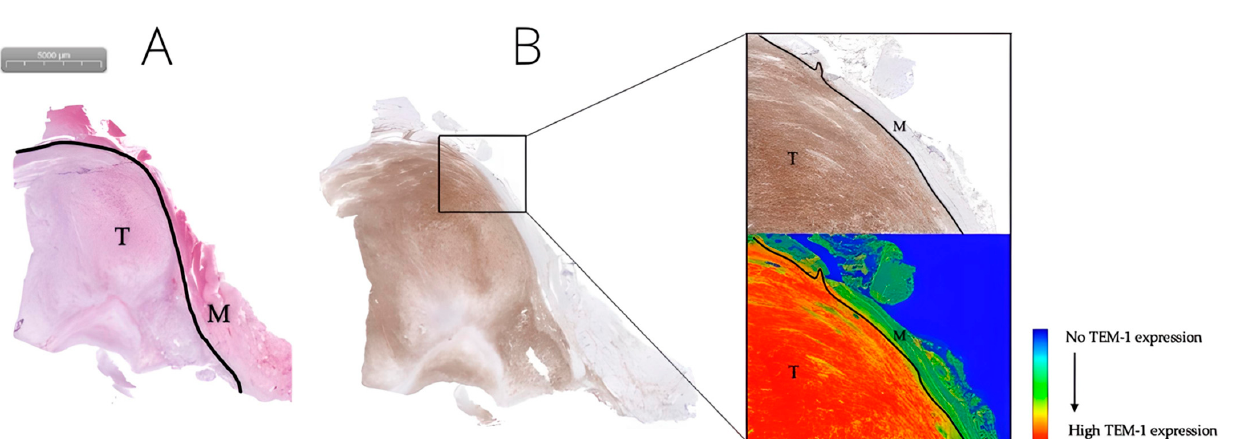
Figure 1. Tissue intensity difference between tumor and adjacent healthy tissue per sample. Exact mean staining intensity values per case are displayed on the left- and right-hand y-axes. TEM-1 displays the highest difference in tumor- versus-adjacent healthy tissue staining intensity. For three cases, VEGF-A staining intensity and PDGFR- α staining intensity were higher in adjacent healthy tissue compared to tumor tissue (shown in red). Samples had a statistically significant higher staining intensity in tumors compared to adjacent healthy tissue for the TEM-1, VEGF-A, and PDGFR- α staining groups ( p < 0.05).